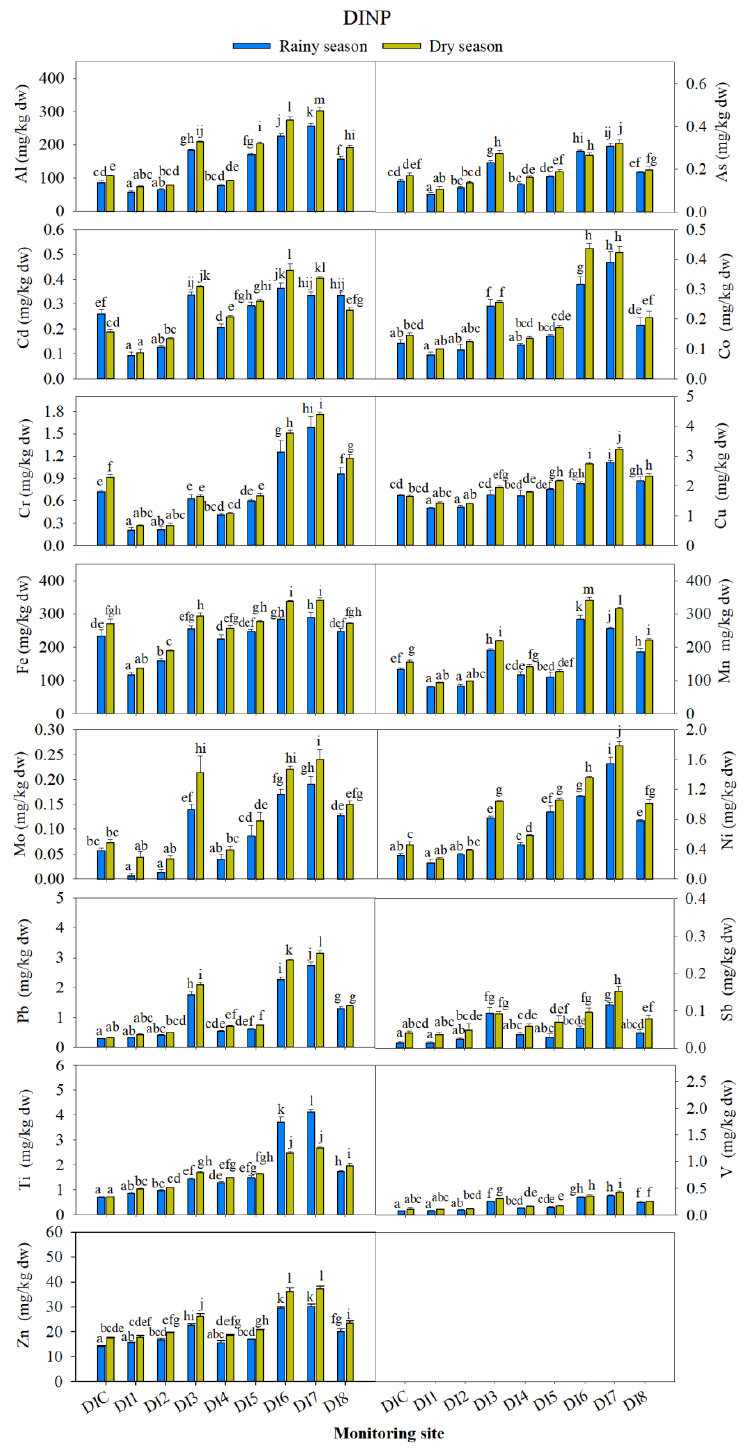
Figure 5. Average concentration of each potentially toxic element (PTE, n = 3) at each site during the rainy and dry seasons in Doi Inthanon National Park (DINP). The different letters on a graph of each PTE indicates statistically significant difference by one-way ANOVA with Tukey test, p < 0.05, n = 3.